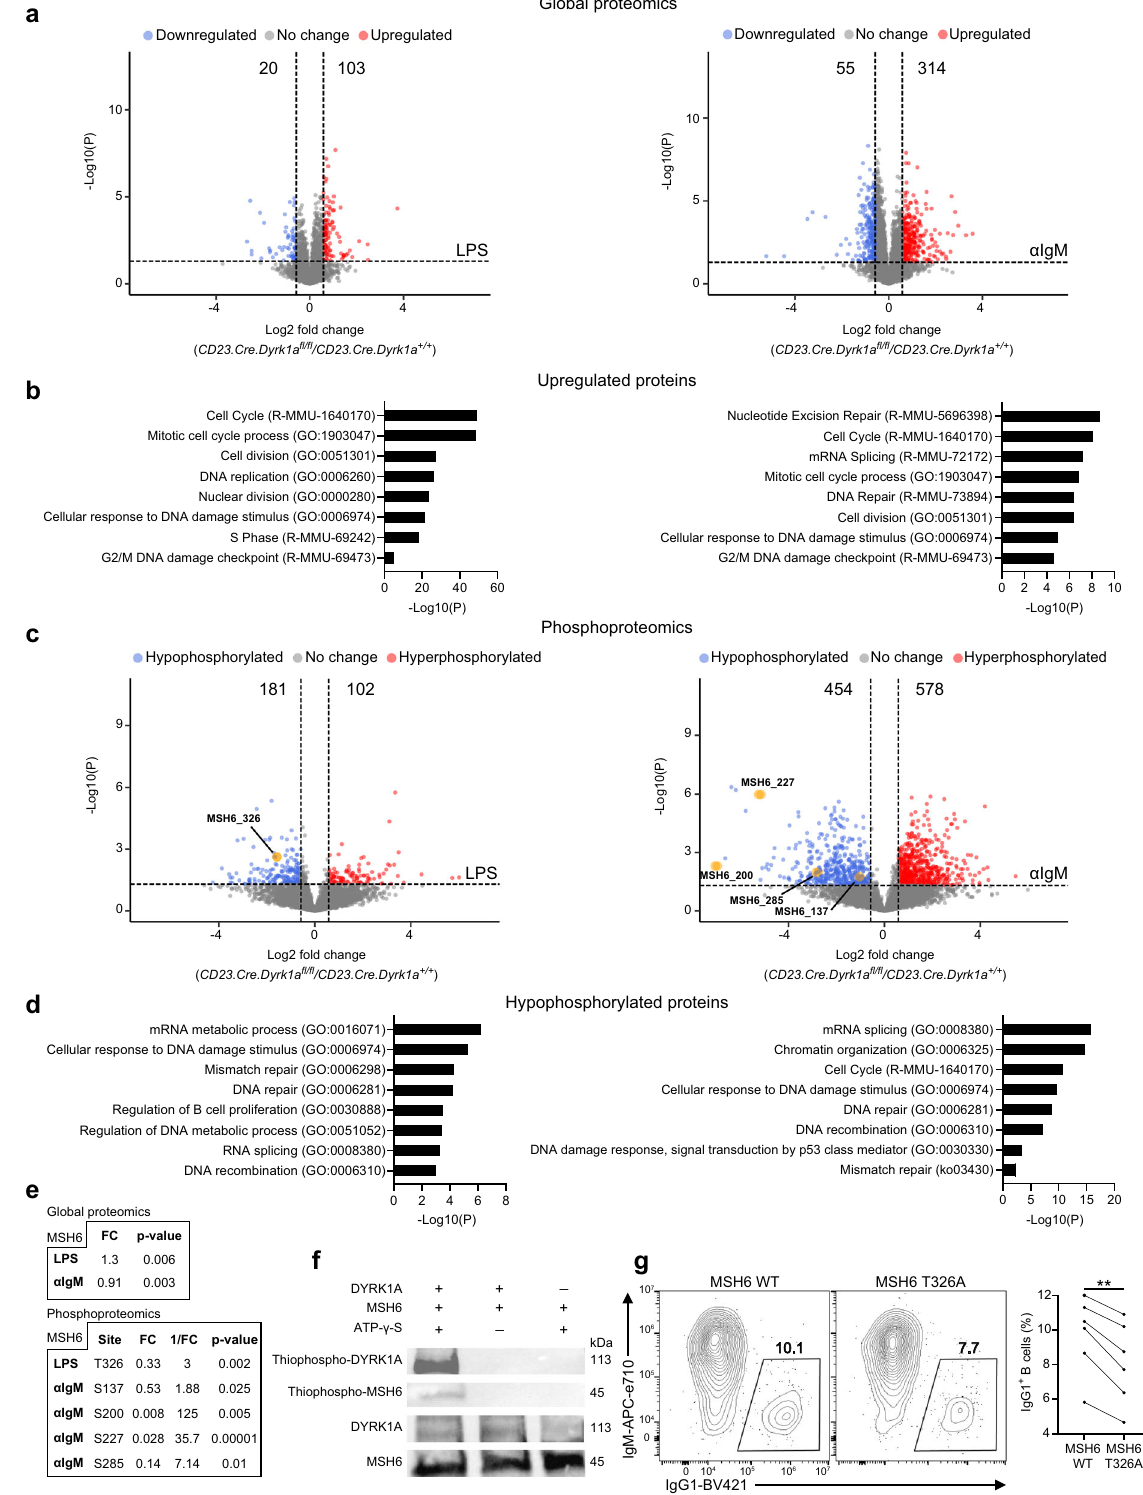
Fig. 2 | MSH6 is a direct target of DYRK1A phosphorylation. a , b Volcano plots depicting changes in protein expression in Dyrk1a -de fi cient B-cell mice compared to WT littermates, which were both stimulated with LPS or α IgM for 3 days ( a ); biological pathway analysis was performed on upregulated proteins ( b ); (hyper- geometric test and Benjamini – Hochberg P value correction by Metascape). c , d Volcanoplotsshowingchangesinspeci fi cphosphorylationsites( c );biological pathwayanalysiswasperformedonhypophosphorylatedsitesinBcellsstimulated with LPS or α IgM for 3 days ( d ); ( n =5; three independent experiments, hyper- geometric test and Benjamini – Hochberg P value correction by Metascape).